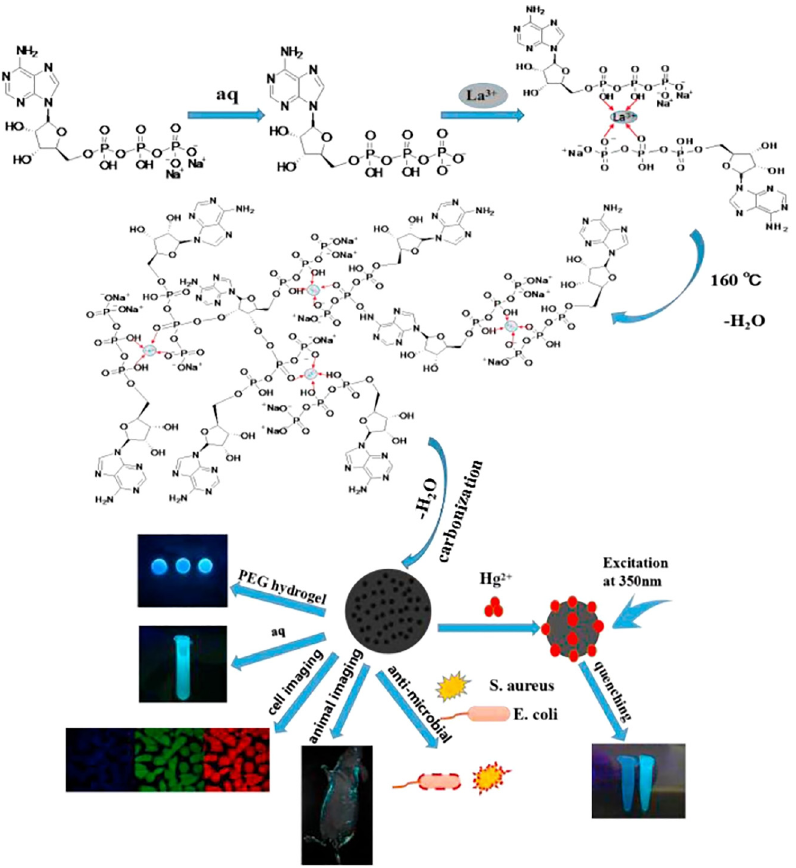
Table  : Typical applications of CDs in HMs